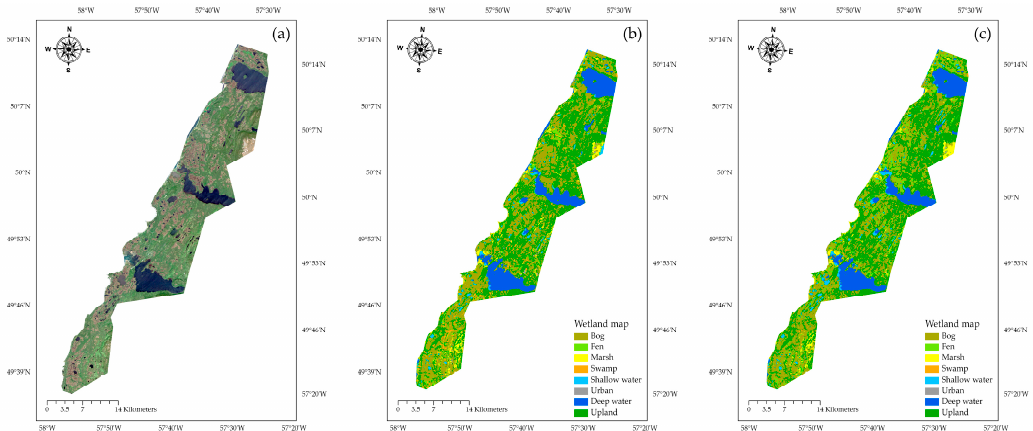
Figure 13. ( a ) A true color composite of RapidEye optical imagery (bands 3, 2, and 1) acquire on June 18, 2015. The classification maps of the Gros Morne study area obtained from ( b ) FP (OA: 90.93%, K: 0.88) and ( c ) simulated CP SAR data (OA: 84.07%, K: 0.80).